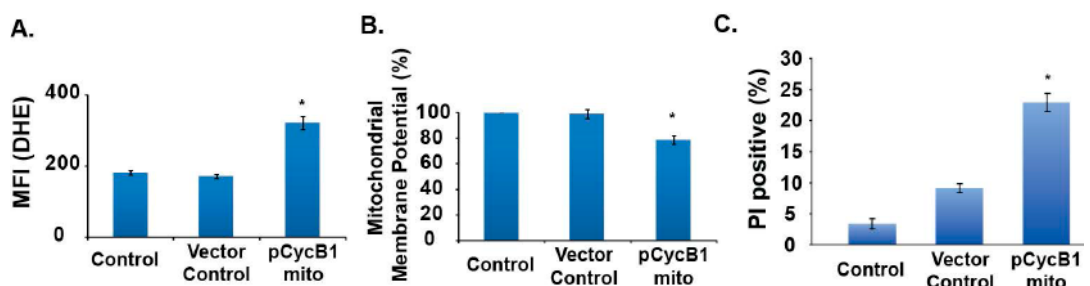
Figure 8. Mitochondria-targeted overexpression of cyclin B1 increased ROS levels, which was associated with a loss in mitochondria transmembrane potential, and cell viability. Quiescent NHFs were transfected following the protocol described in Figure 7. Control and transfected cells were harvested at 48 h post-transfection and used for flow cytometry measurements of ( A ) ROS levels, DHE oxidation, ( B ) mitochondrial transmembrane potential, JC-1 fluorescence, and ( C ) cell viability, PI staining of unfixed cells. n = 3, * p < 0.05.